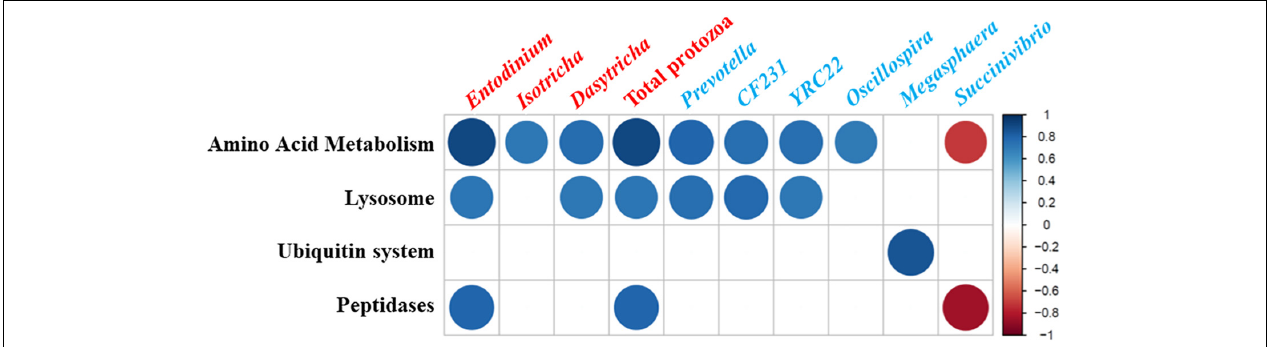
FIGURE 3 | Correlations between microbial taxa [log-transformed counts of protozoal genera (labeled in red) and relative abundances of bacteria (labeled in blue) were used] and relative frequency of CowPI-predicted functional features related to protein metabolisms in the in vitro cultures. Only the strong correlations (Pearson correlation coefficient, | r | > 0.8; P < 0.05) were shown. The size and intensity of the color of each circle indicate the degree of the correlation coefficient based on the color key on the right side.